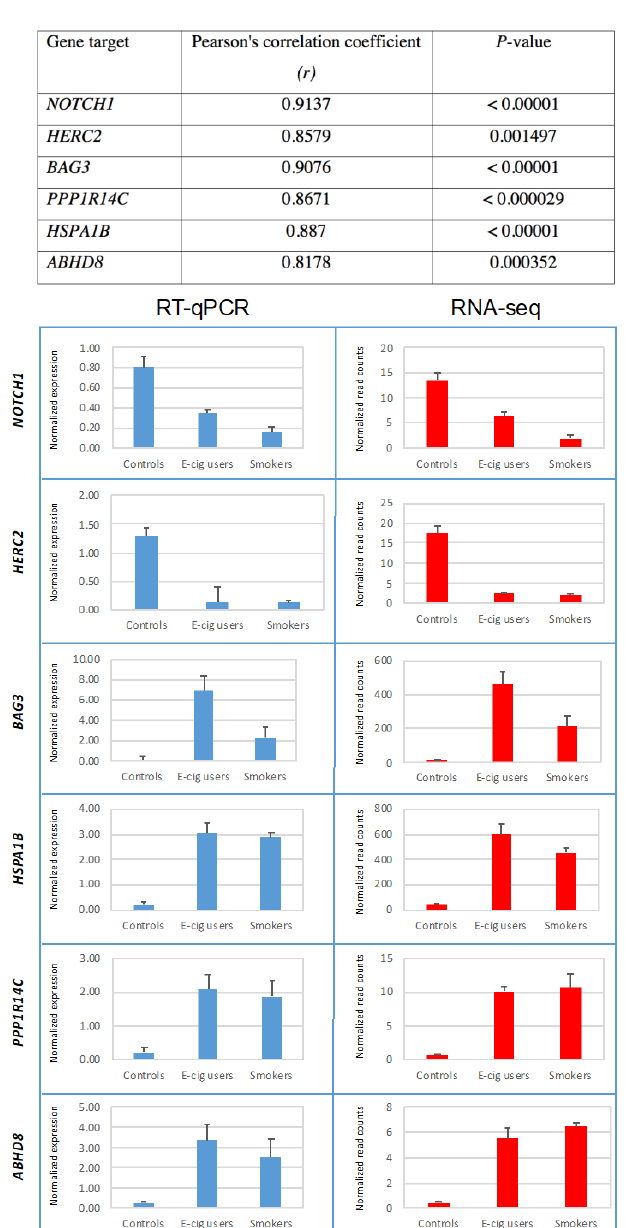
Figure 6. Validation of RNA-seq gene-expression data by RT-qPCR. Transcription levels of several up- and down-regulated targets identified by RNA-seq in e-cig users and smokers were validated by RT-qPCR. Results are expressed as the median normalized expression levels + Standard Error (SE).